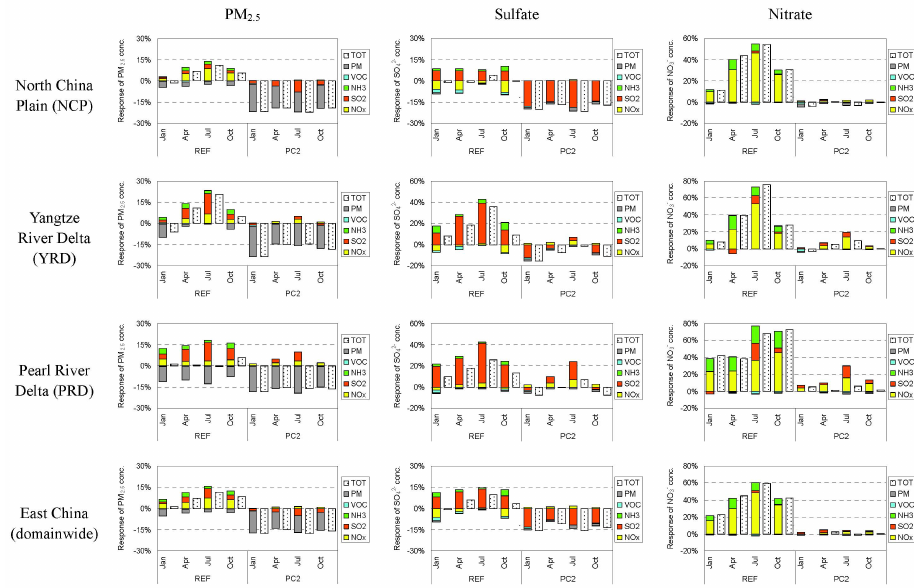
Fig. 8. Percentage changes of surface PM concentrations relative to the 2005 scenarios in 2020 (monthly average; TOT represent the differences between two future scenario with 2005 baseline, PM, VOC, NH 3 , SO 2 , NO x represent the individual impacts of their emission changes in